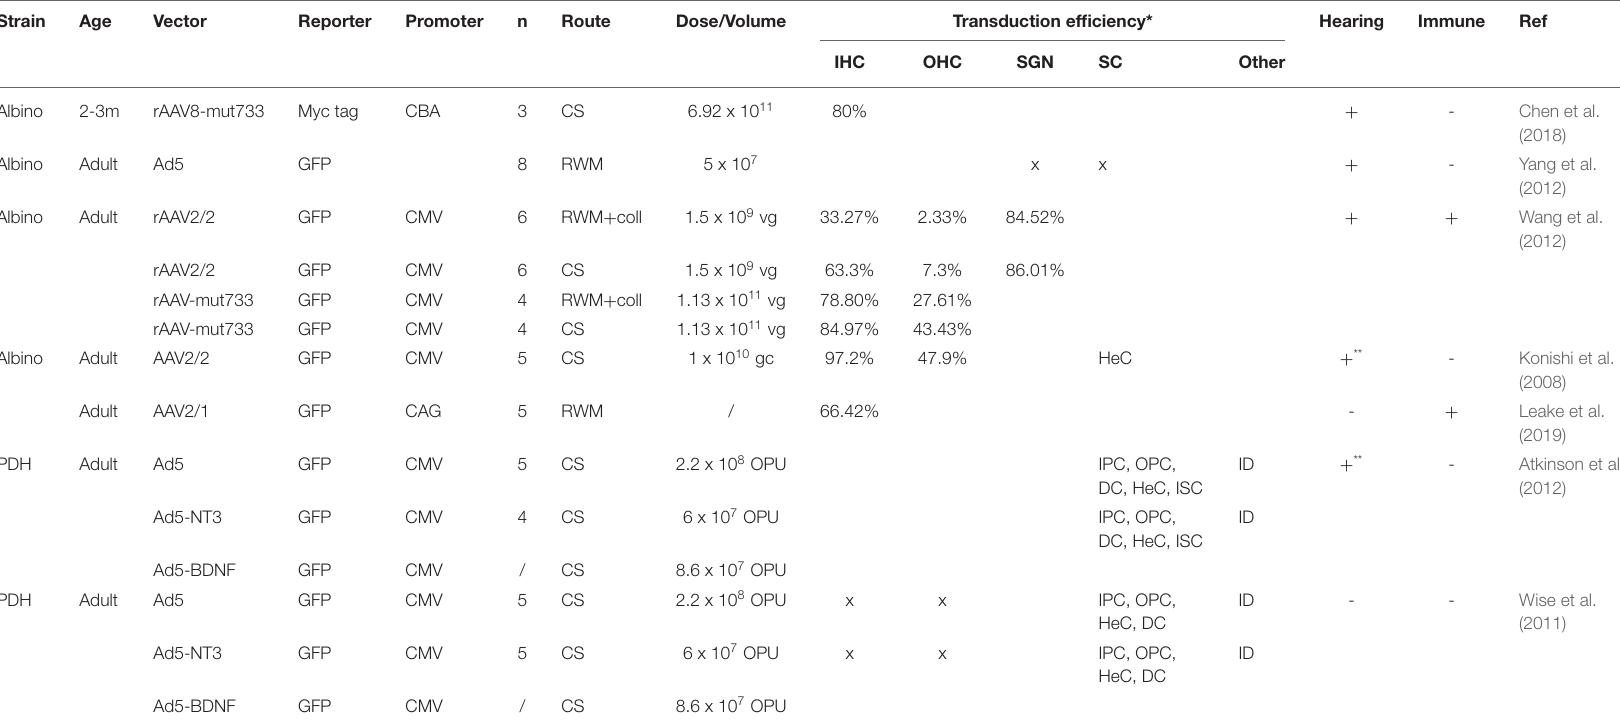
TABLE 2 | Summary of extracted data from gene therapy studies performed in guinea pigs.